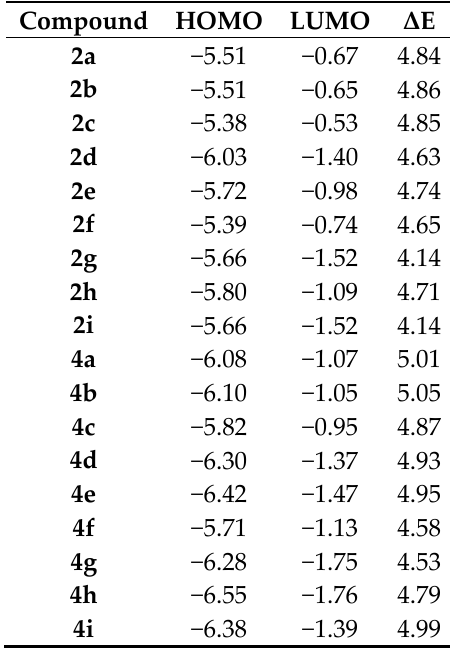
Table 1. The values of HOMO and LUMO energies for compounds 2a – 2i and 4a – 4i along with the energy gaps ( Δ E). All energy values are reported in eV